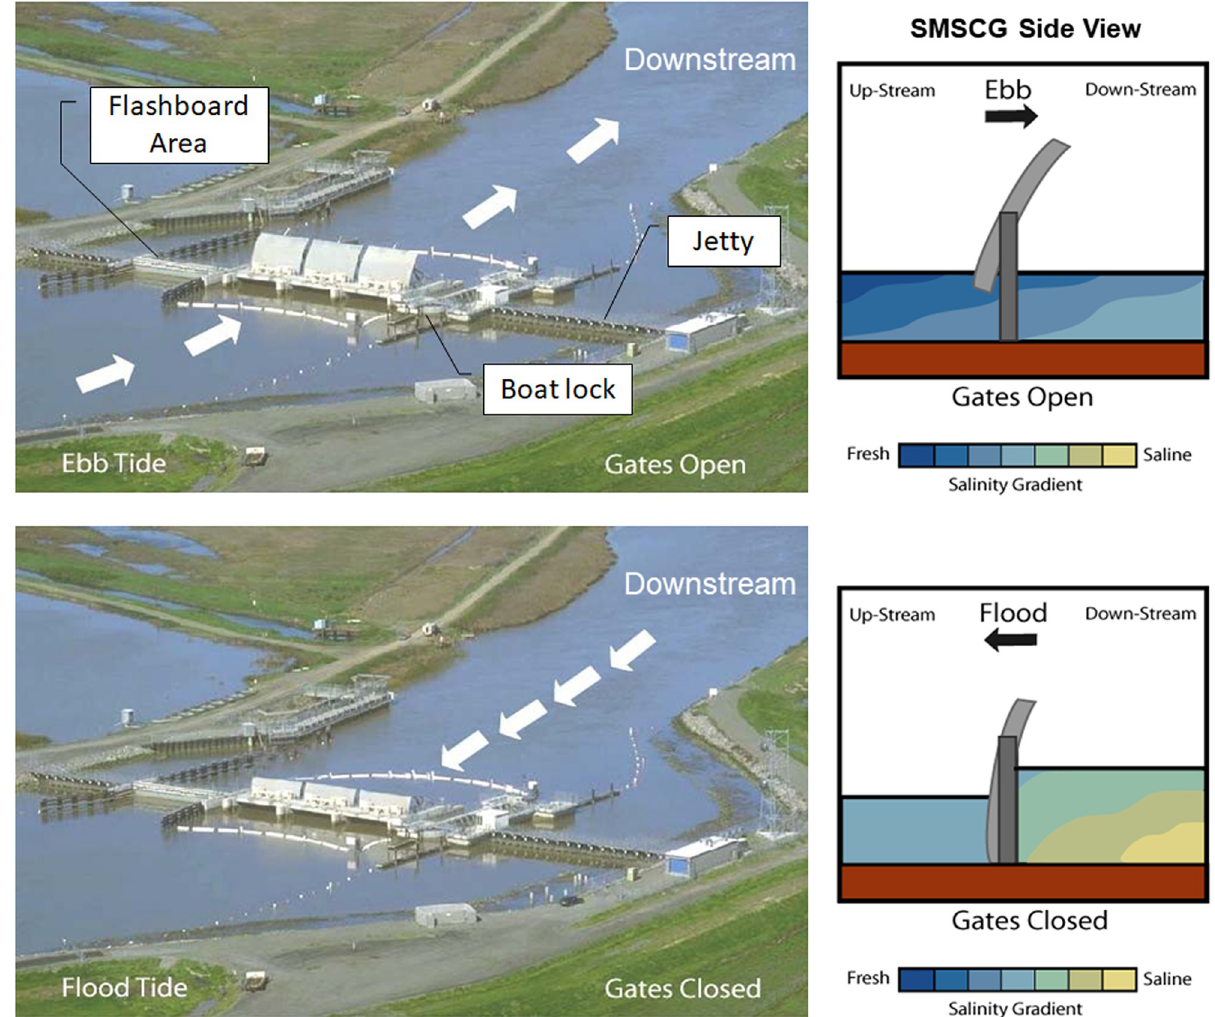
Fig 2. Suisun Marsh Salinity Control Gates. Under typical operations, the gates are opened during ebb tide (upper panels) and closed during flood tide (lower panels) to tidally pump low salinity water into Suisun Marsh.